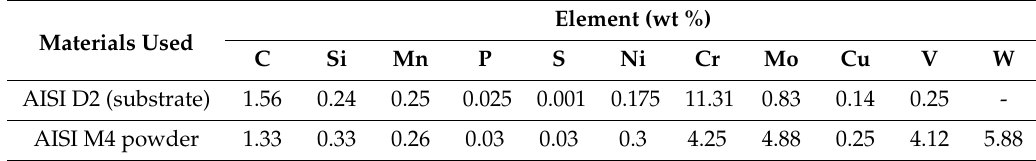
Figure 1. M4 powder image and the particle size for the laser deposition. Table 1. Chemical composition of the materials. (unit: wt % ).